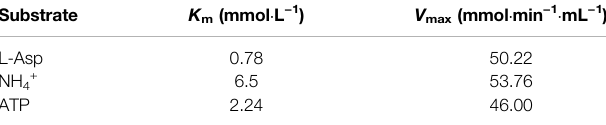
TABLE 3 | Kinetic parameters of Lsa AS-A.